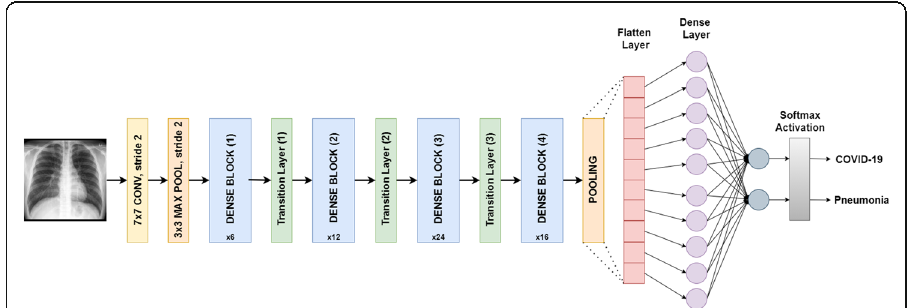
Fig. 3 DenseNet121 architecture designed for binary